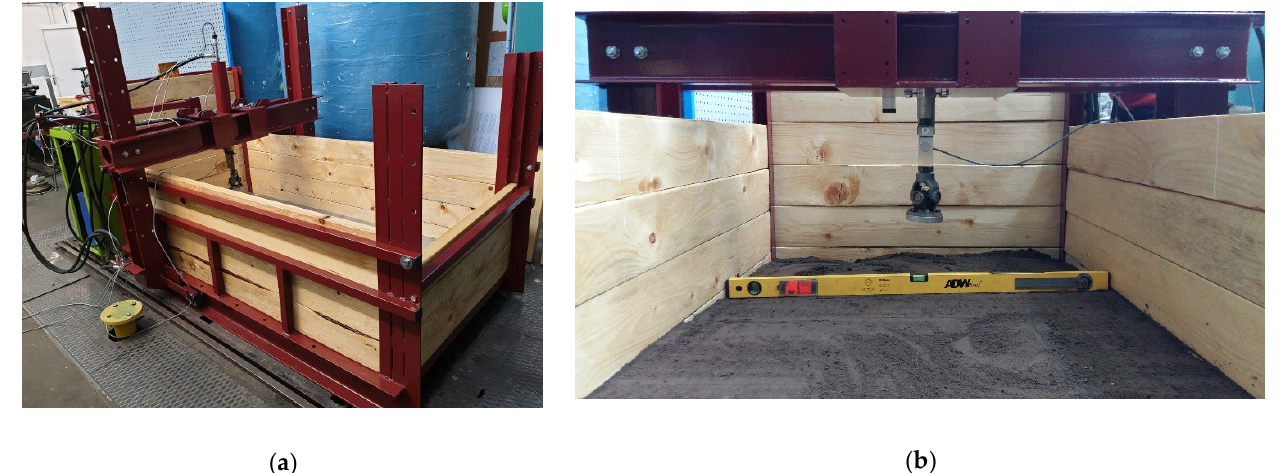
Figure 1. ( a ) Plate sinkage test (bevameter device); ( b ) soil surface leveling.